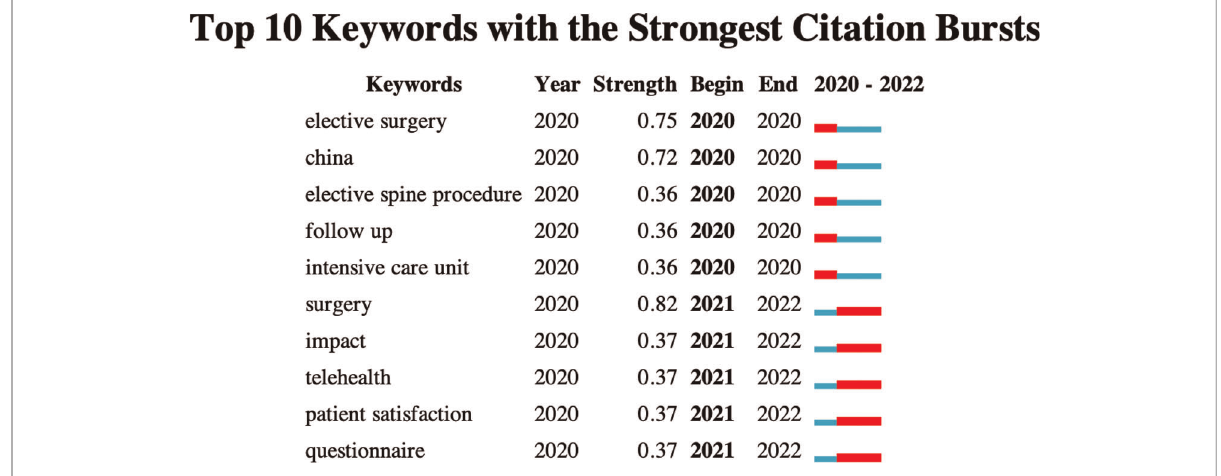
FIGURE 8 Top 10 keywords with the strongest citation bursts (generated by